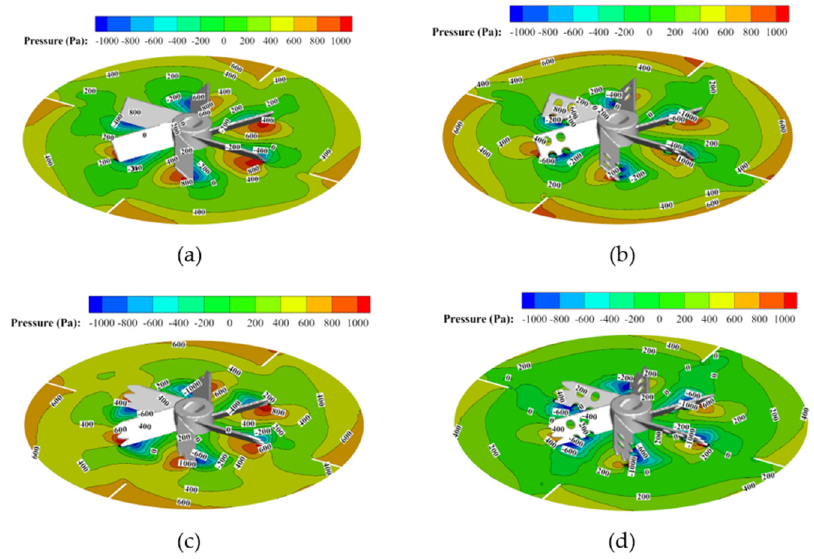
Figure 10. Contour plots of pressure on the center plane of impellers at z = 0.25 H , ( a ) PBT, ( b ) PBPT, ( c ) BCBT, ( d ) BCPBT.